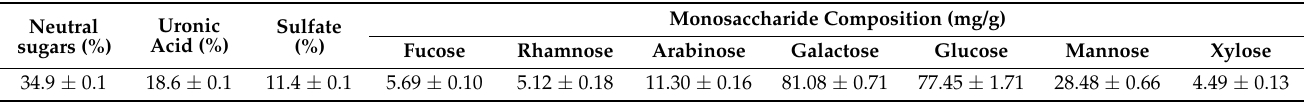
Table 1. The chemical composition of